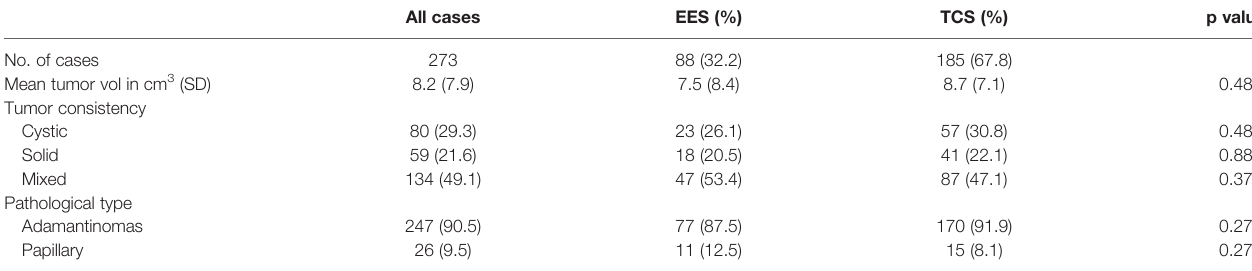
TABLE 2 | Tumor size, histopathological subtype, and